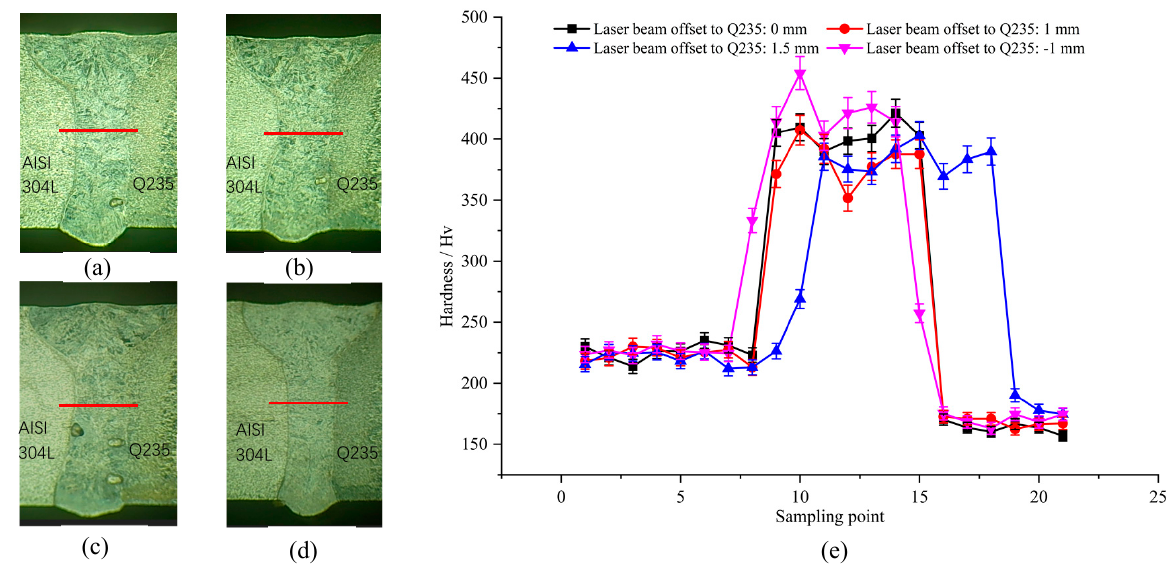
Figure 14. The cross-section views and hardness test results with different laser beam offsets: ( a ) laser beam offset = 0 mm; ( b ) laser beam offset = 1 mm; ( c ) laser beam offset = 1.5 mm; ( d ) laser beam offset = − 1 mm; ( e ) hardness test results. Table 7. The average hardness values of the welded joints with different laser beam offsets. Experiment with Laser Beam